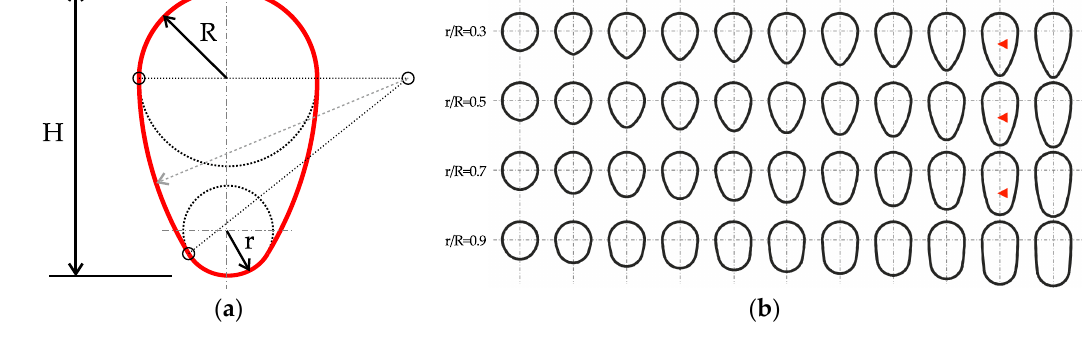
Figure 1. ( a ) Egg ‐ shaped cross ‐ section definition from variables H, R, and r with a tangent connecting top and bottom arcs and ( b ) H/R and r/R relationships. The best egg ‐ shaped cross ‐ sections are highlighted with triangles. Table 1. Comparison of hydraulic radius ( R h ) for low flows (1:10, 1:20, and 1:50 wastewater and rainfall rates) and full ‐ bore section discharges ( Q 0 ) conditions in egg ‐ shaped cross ‐ sections with best hydraulic performance. Hydraulic radius and discharges were normalized with circular cross ‐ section values.